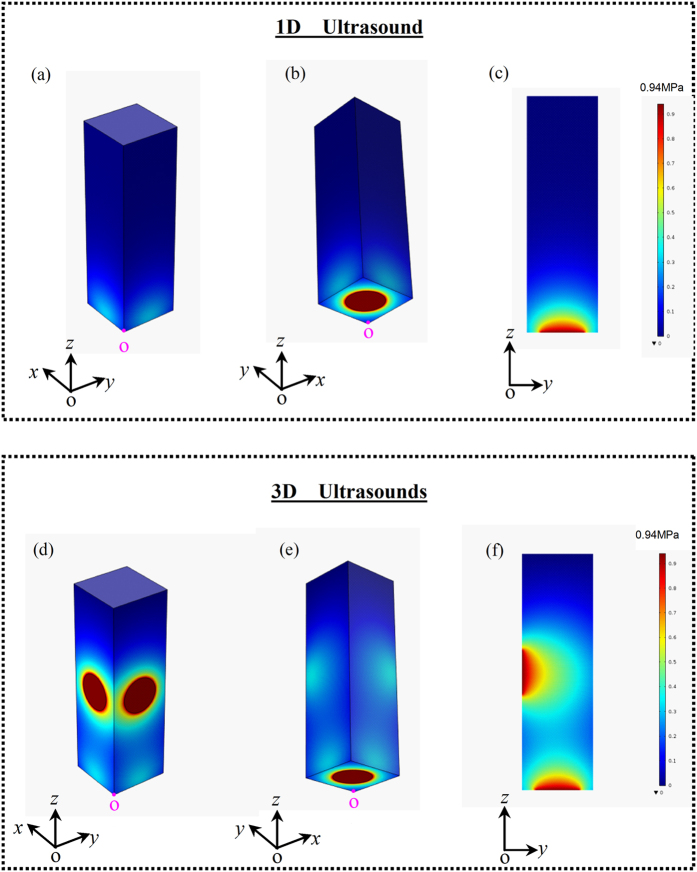
Numerical analysis on the sound pressure distribution within liquid Al71.9Sn20.4Cu7.7 alloy: (a)~(c) acoustic field in liquid alloy from different views within 1D ultrasound; (d)~(f) acoustic field in liquid alloy from different views within 3D ultrasounds.